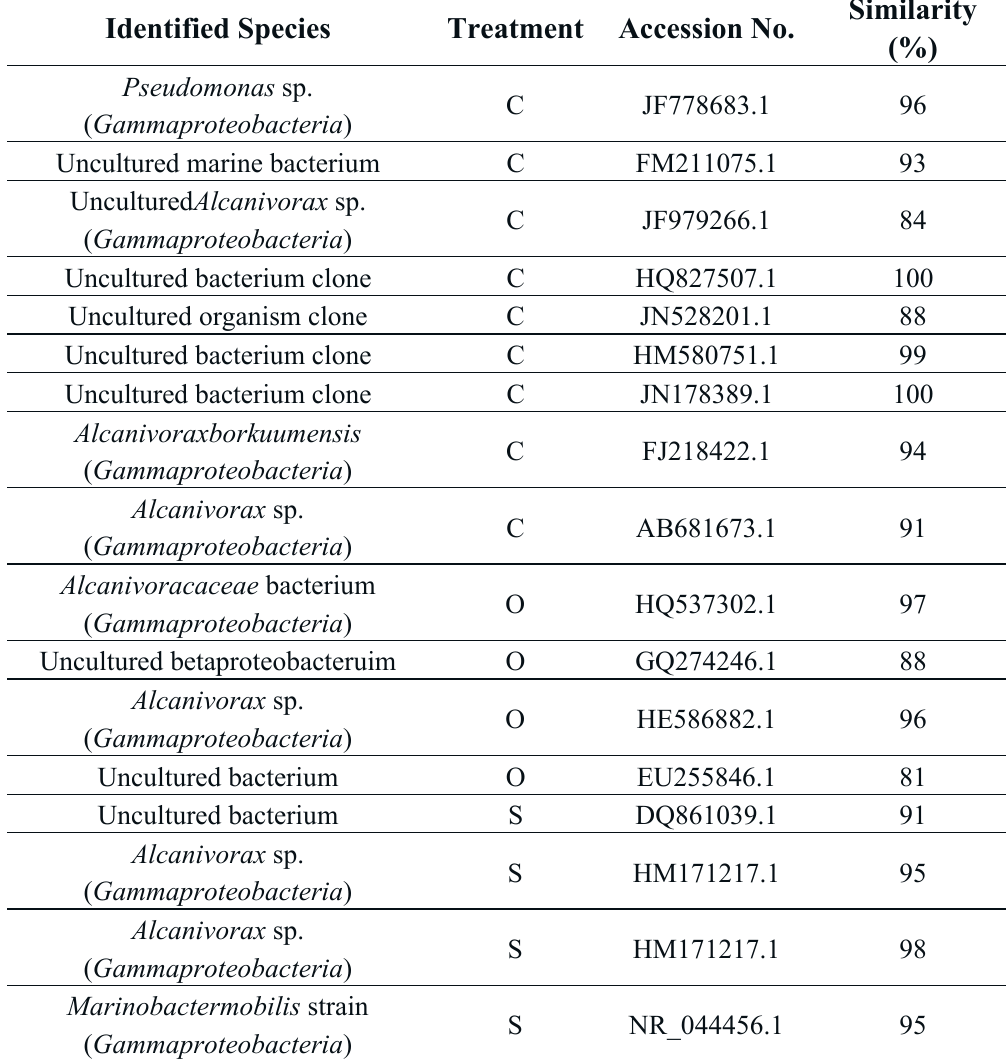
Table 1. Different bacterial species identified from the TGGE gel bands excised in three different treatments (C, O and S), their identity and similarity. Accession